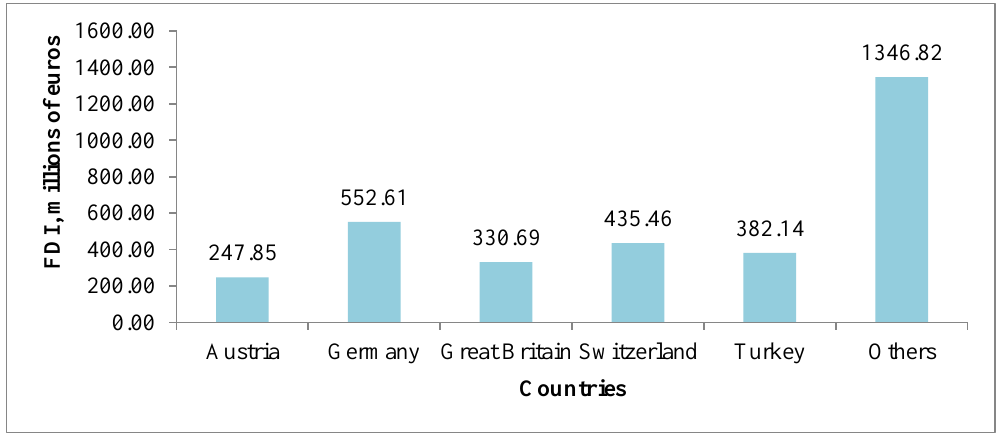
Fig. 2. FDI by top 5 countries and others, 2007–2017, in millions of euros (developed by the authors based on CBK data,